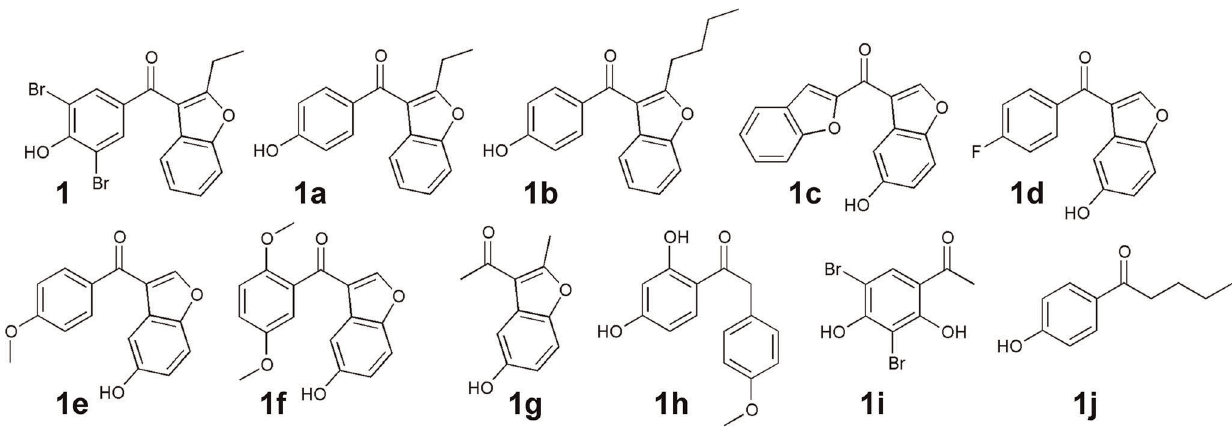
Figure 4. Structure-activity relationships. Chemical structures of compounds related to Benzbromarone (1a–1j) that were assayed for their ability to inhibit the phosphatase activity of Eya3(ED), EYA3, and PTP1B. IC50 values are in Table 1.